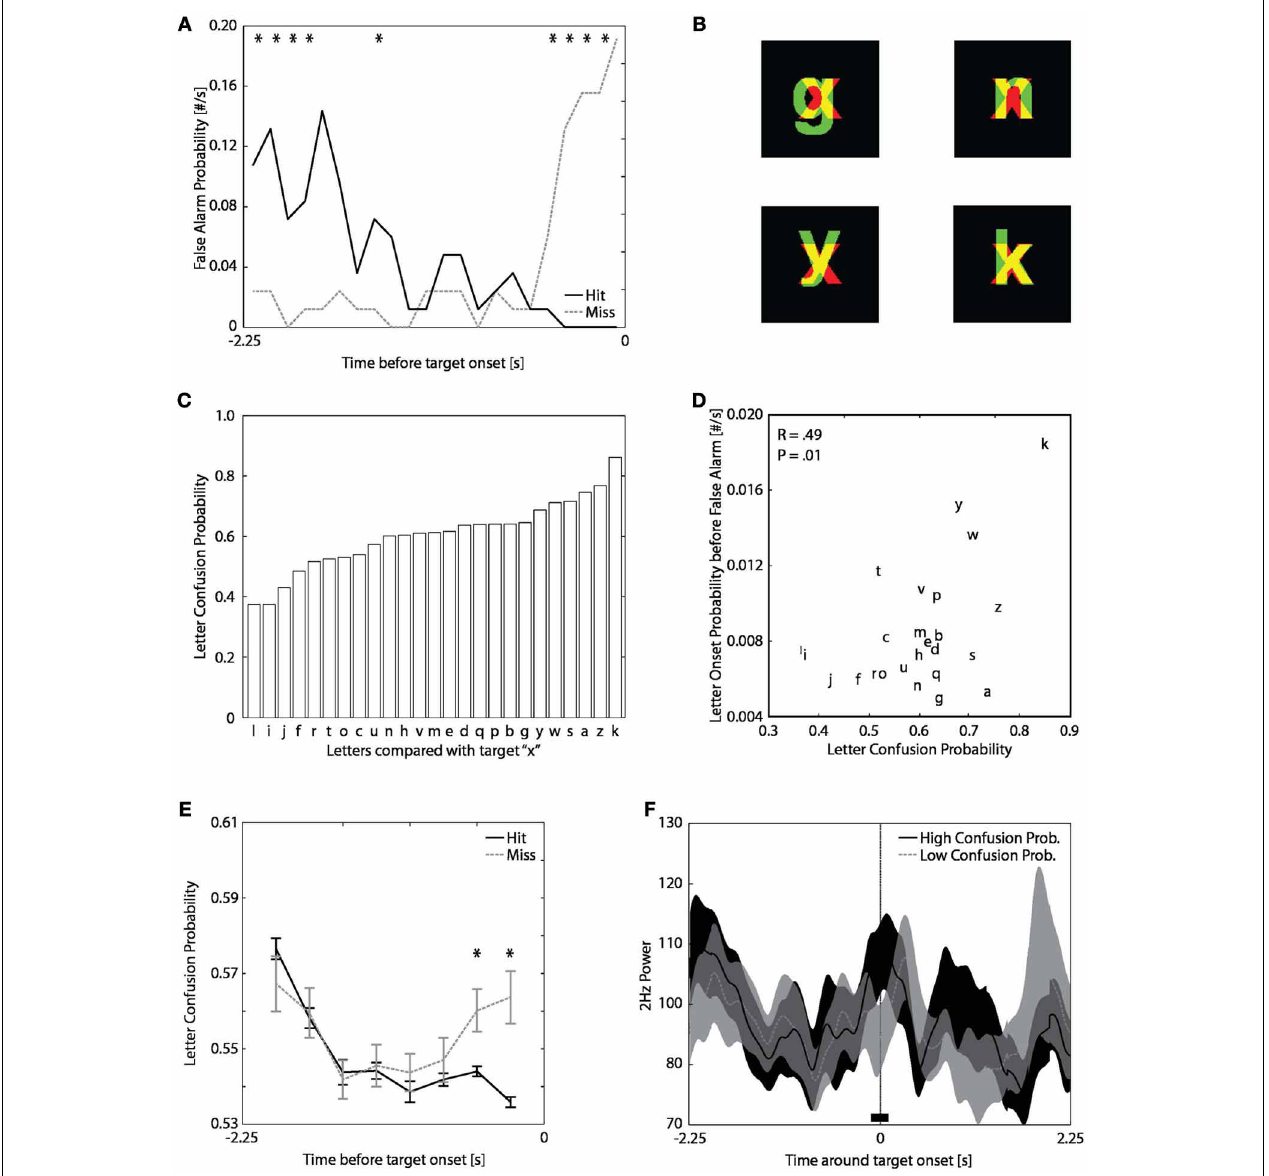
FIGURE A4 | False alarms, confusing letters, and misses. (A) Probability that an observer false alarmed to the onset of a non-target as a function of time before target onset per hits ( black ) and misses ( gray ). ( ∗ p < 0 . 05) (B) Examples of overlapping letters. Images were created by presenting each of the two letters in the separate red and green color channel such that the overlap in letters is indicated in yellow . (C) The probability to confuse a non-target letter with the letter “x” based on the amount of overlap in (B) .